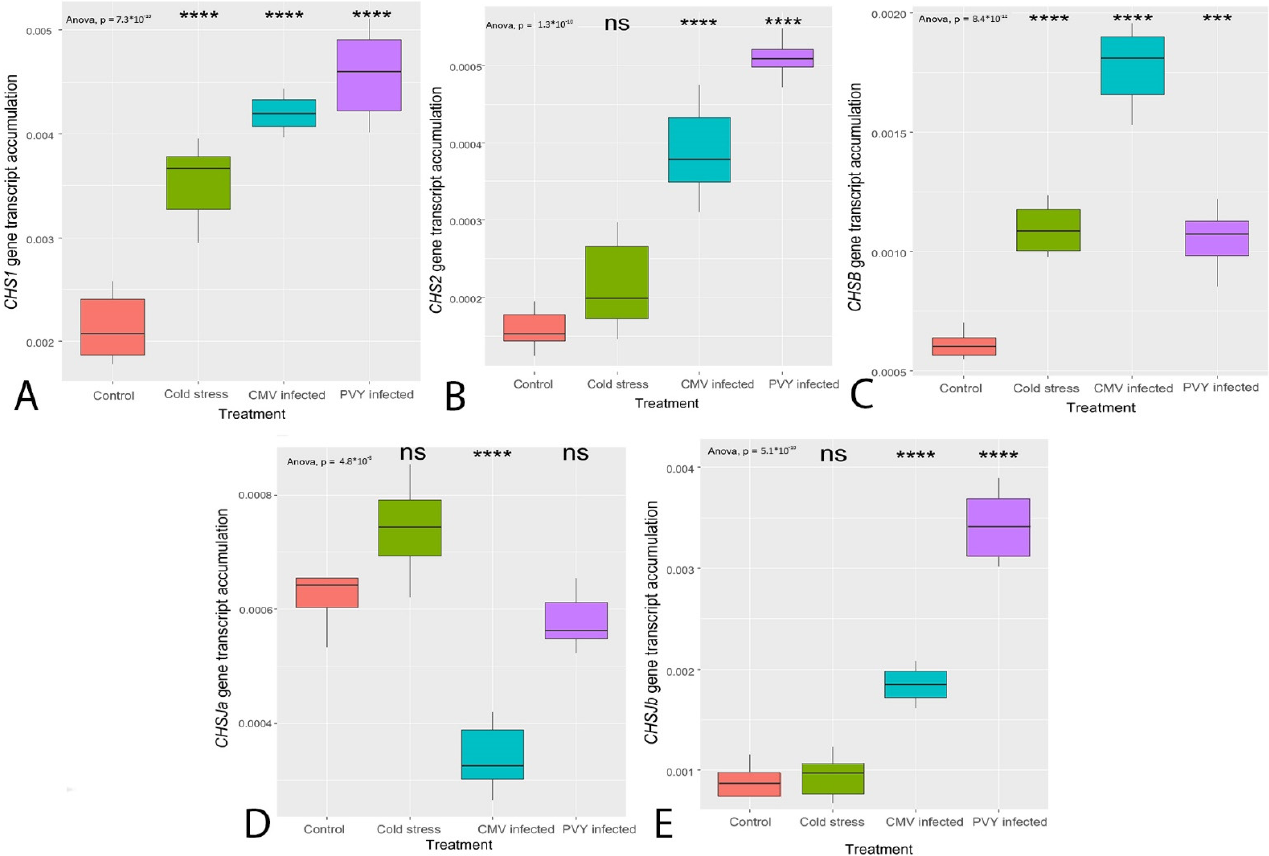
Figure 5. Transcription of the genes encoding for chalcone synthase (CHS) isoenzymes (( A ): CHS1, ( B ): CHS2, ( C ): CHSB, ( D ): CHSJA, ( E ): CHSJB of tomato leaves (cv. Elpida) following plant exposure to cold stress (5 °C for 16 h) or inoculation (20 d) with either cucumber mosaic virus (CMV) or potato virus Y (PVY). Significant differences were determined by one-way ANOVA comparisons ( p ≤ 5%). Signif. codes: ns: non-significant; 0.05: *; 0.01: **; 0.001: ***; 0: ****.